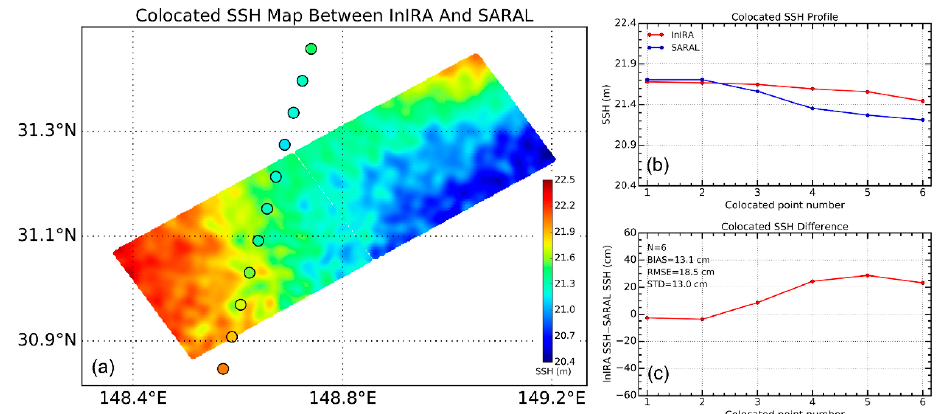
Figure 2. Comparison of sea surface height (SSH) measurements between the Interferometric Imaging Radar Altimeter (InIRA) and colocated Saral/AltiKa altimeter. ( a ) SSH map from the InIRA (large rectangle) and Saral/AltiKa (small circles), ( b ) SSH profile along the Saral/AltiKa track, and ( c ) SSH difference along the Saral/AltiKa track.